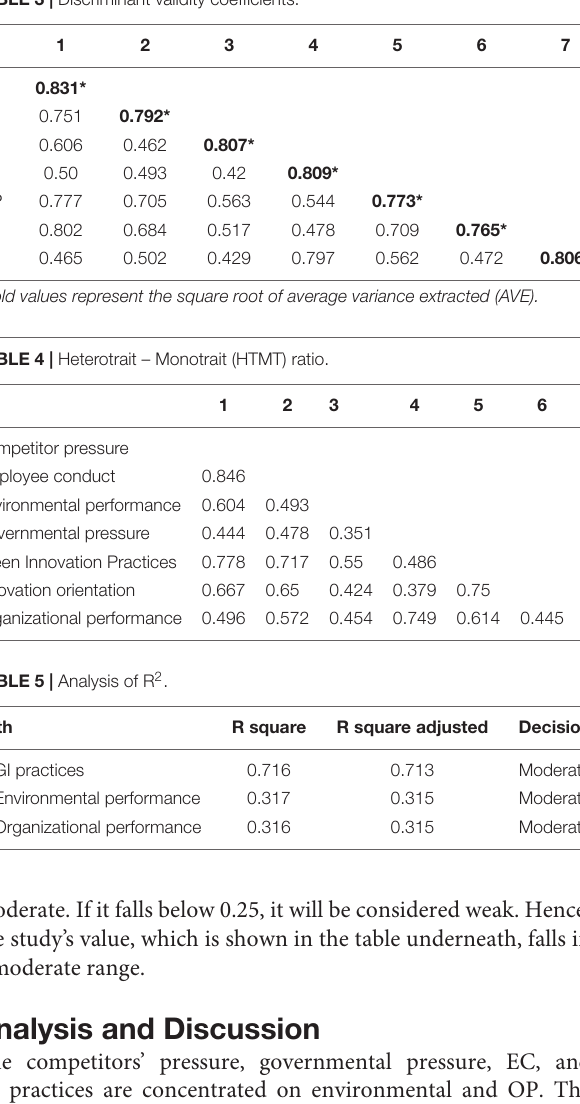
TABLE 6 | Path coefficients and hypothesis